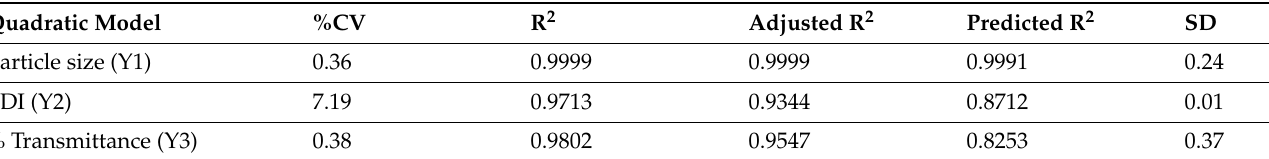
Table 4. Regression analysis summary for responses Y1 (particle size in nm), Y2 (PDI), and Y3 (%transmittance).